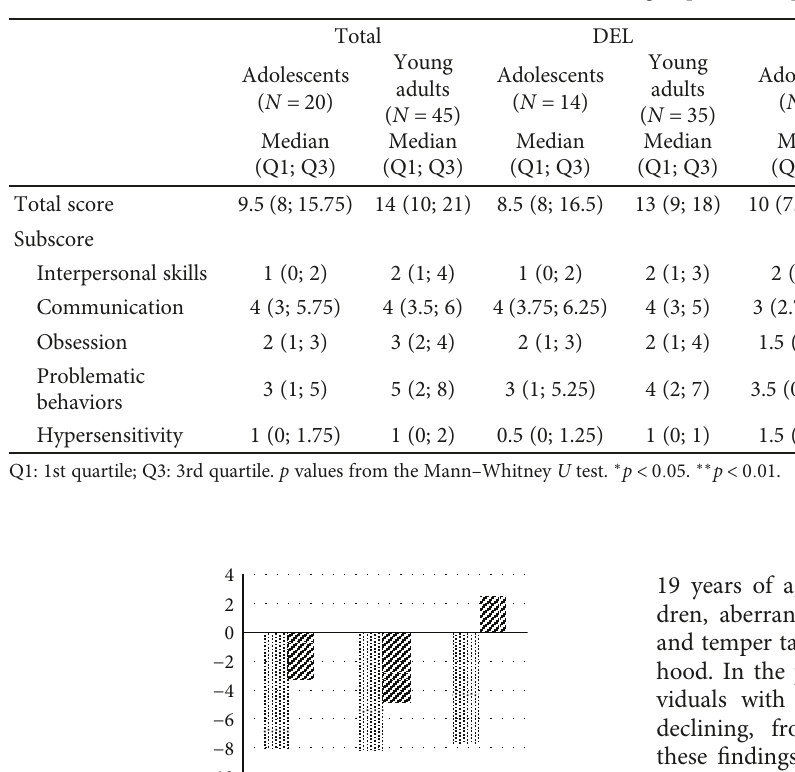
Table 4: PARS total scores and subscores in the groups and comparison of the two age groups.